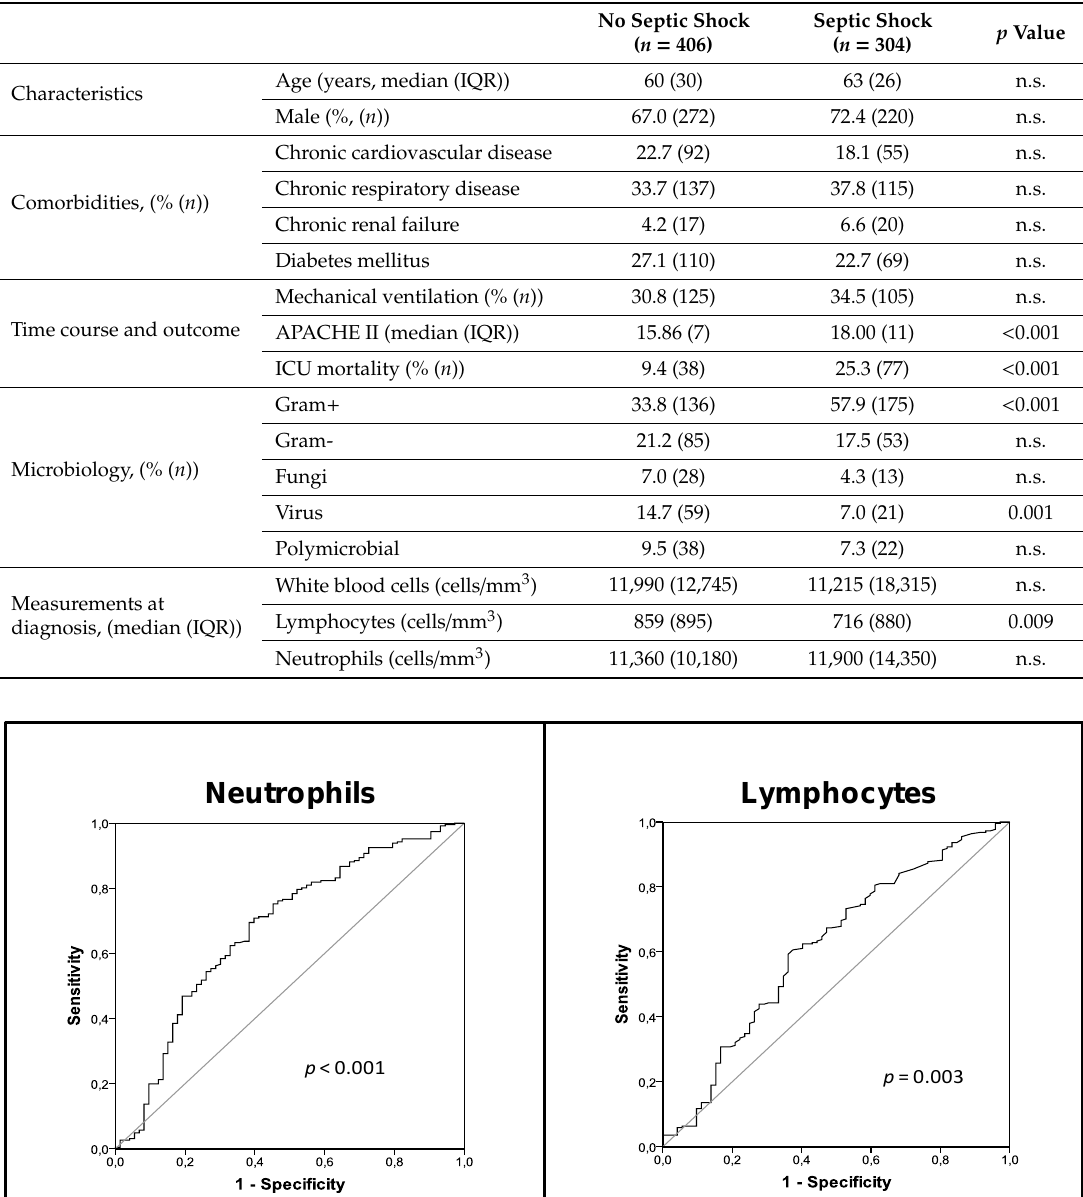
Table 1. Clinical characteristics of the studied groups. n.s: not significant.